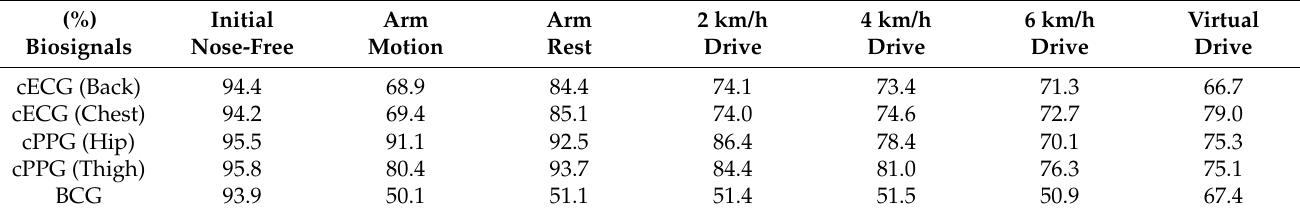
Figure 6. The signal quality index derived by the similarity of the average tCC of the original signals in each movement period ( left column ) and in the rest state after the arm motion task ( right column ). Table 1. SQI atCC of unobtrusive biosignals depending on each